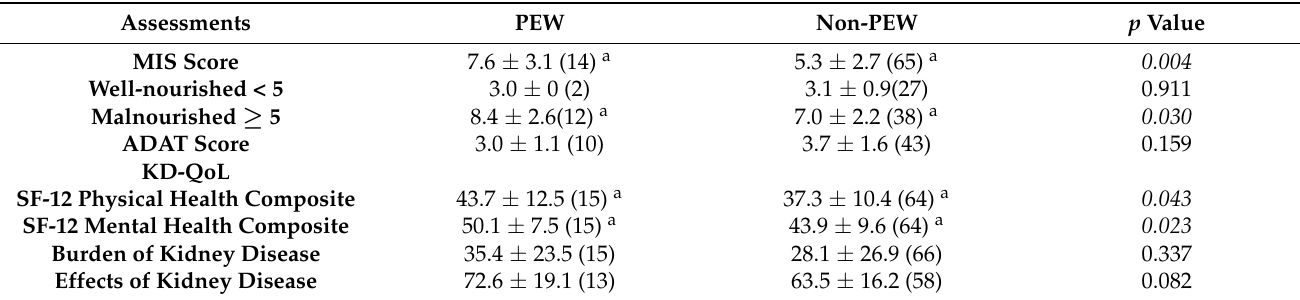
Table 3. Health and Nutrition assessments between PEW versus Non-PEW groups.